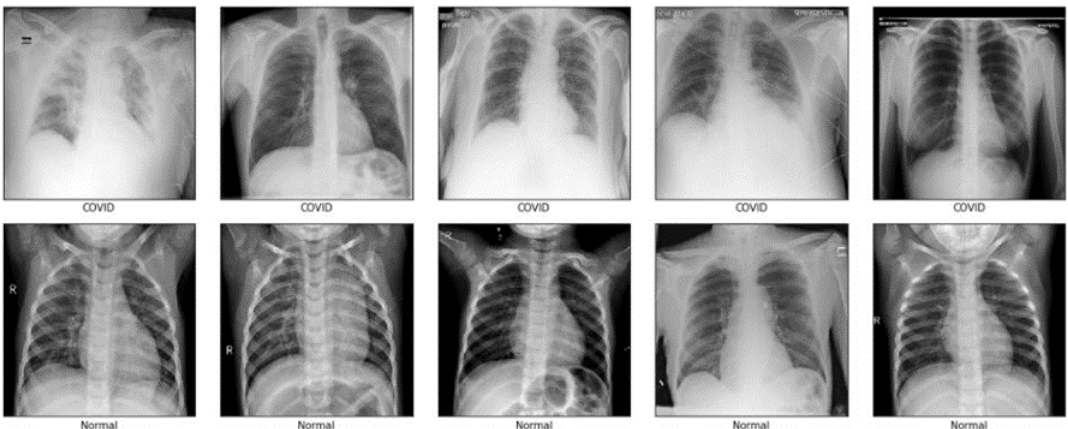
Figure 1. Random samples of the two classes (COVID-19 class and normal class).